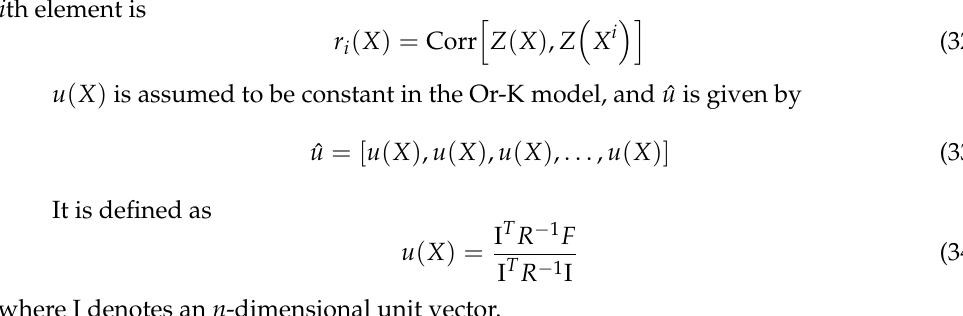
is the output of evaluation function at